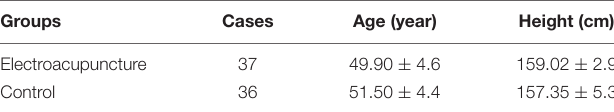
TABLE 1 | Comparison of age and height between the two groups of patients. Groups